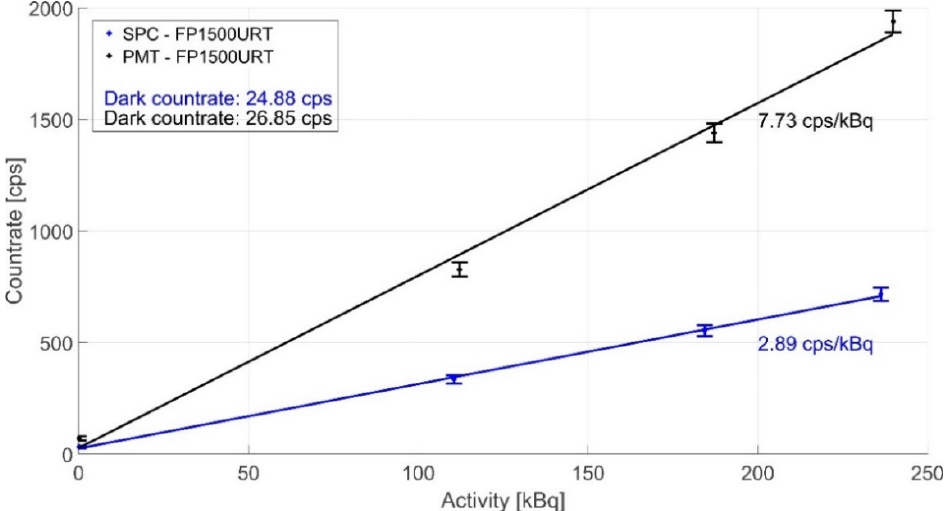
Figure 5. A comparison of the averaged data from SPC and PMT detectors in the optical fibre dosimeter configuration with an LYSO(Ce) scintillation crystal and FP1500URT optical fibre with a length of 1 m and ID1–ID3 gamma radiation source.